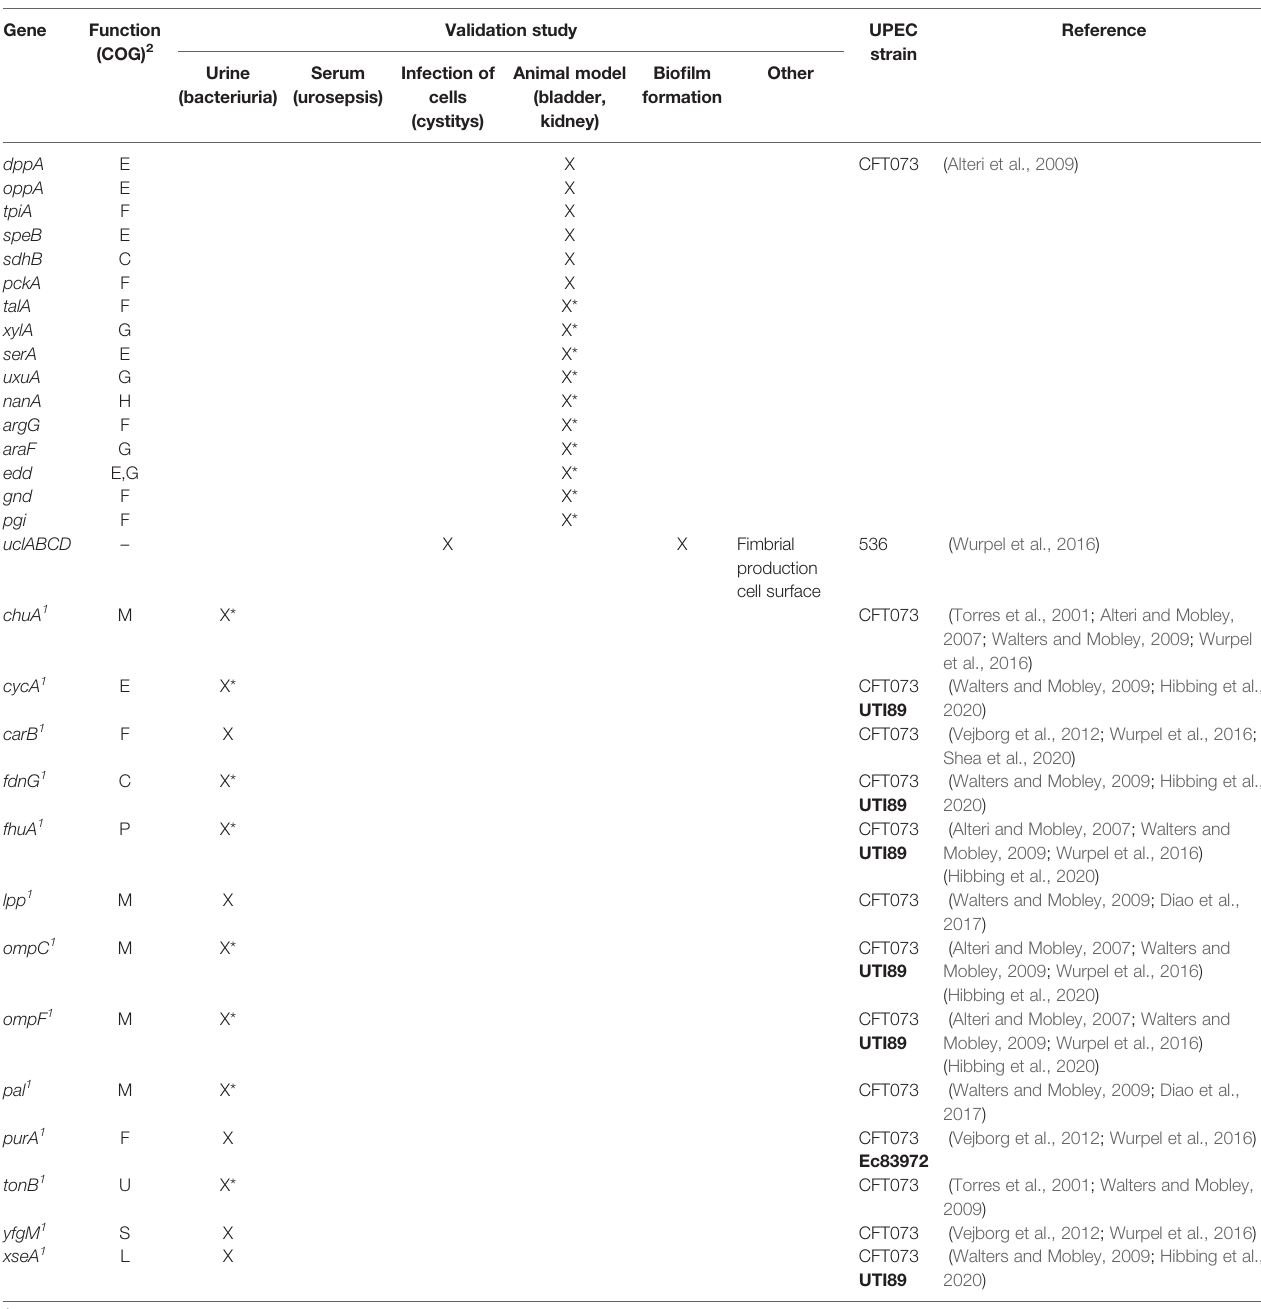
TABLE 3 | Validated genes identi fi ed by